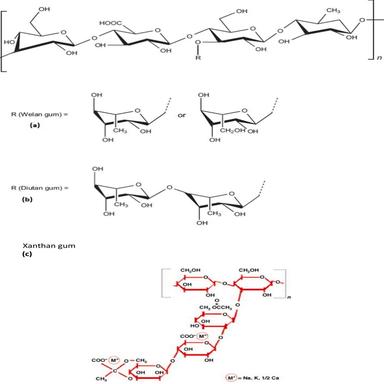
Structure of (a) welan gum, (b) diutan gum and (c) xanthan gum Reproduced respectively from and with permission.